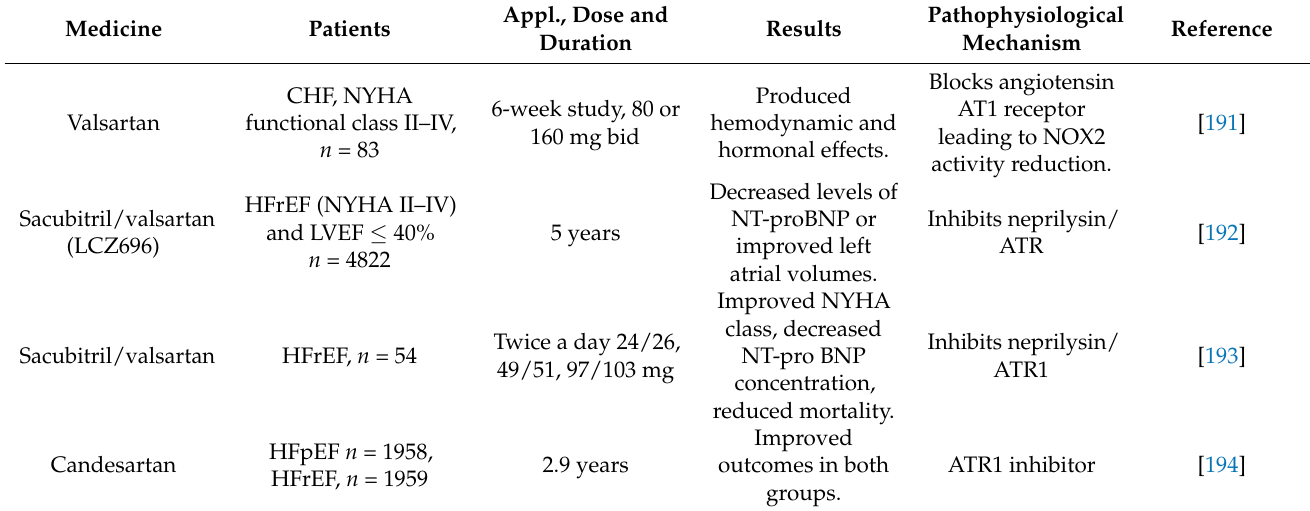
Table 1. Medicines affecting human cardiomyocytes via renin-angiotensin system in HF